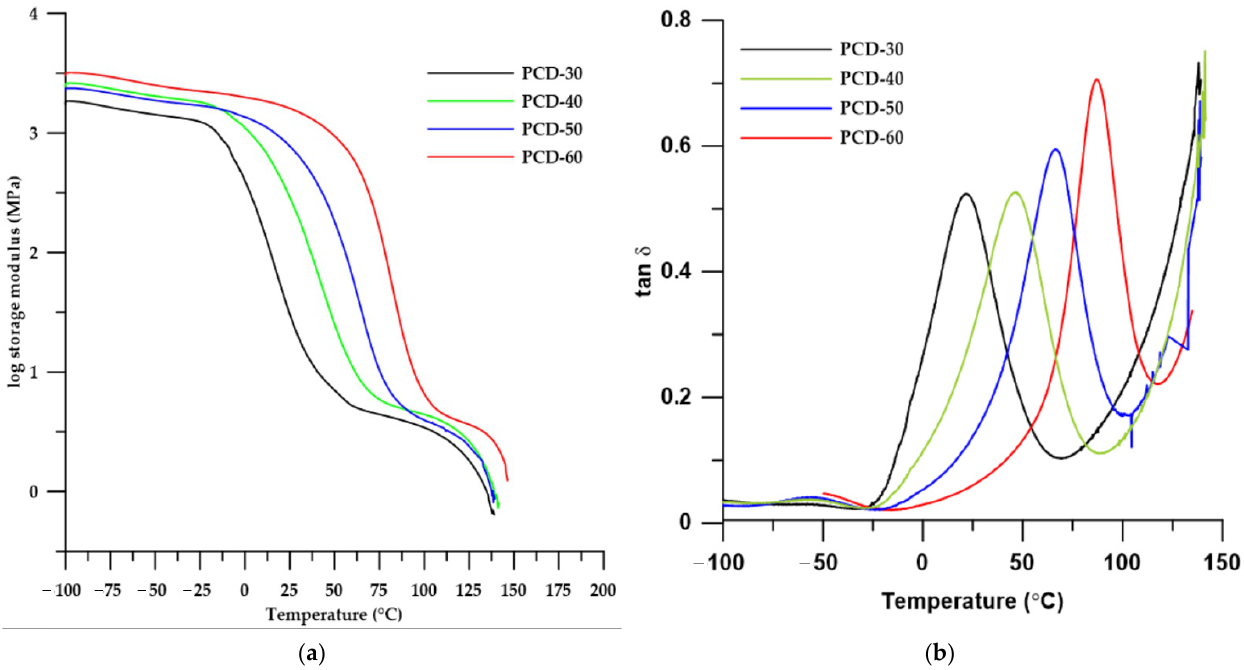
Figure 8. Temperature dependence of storage modulus ( a ) and tan δ ( b ) of synthesized PTURs. Table 6. DMTA results of the